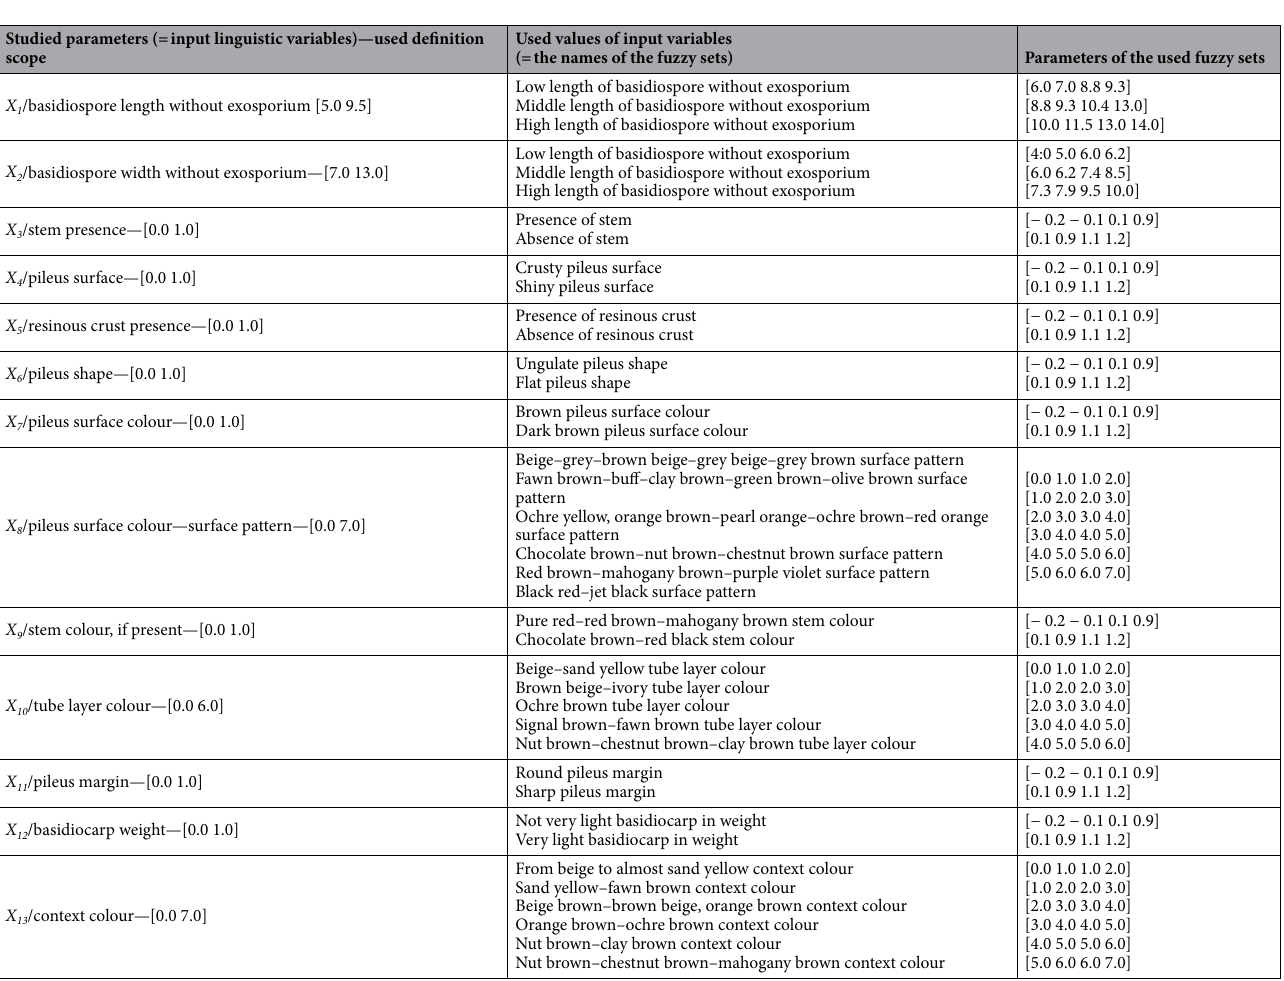
Table 2. List of the used parameters of input linguistic variables.